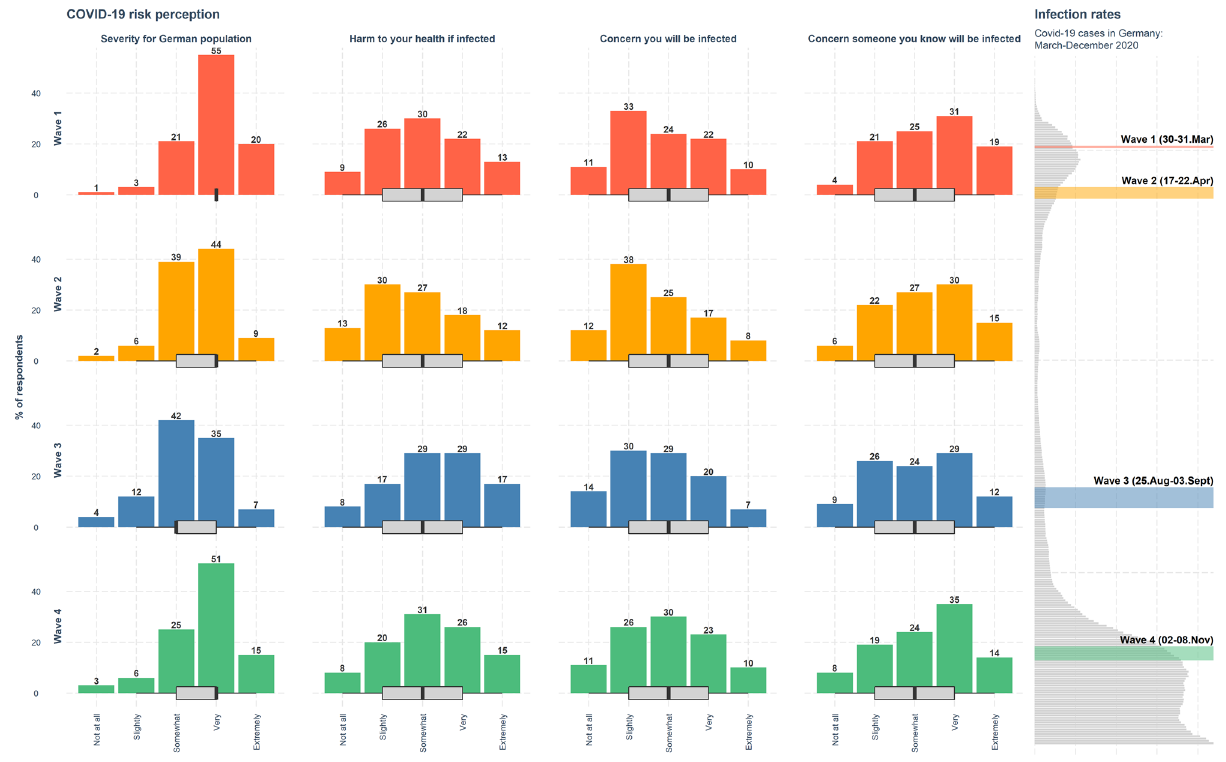
Figure 3. Perceived risks from COVID-19 across the four waves of the study. Barplots show the distribution of responses to the four items (with percentages). Boxplots show the interquartile range (IQR; responses between the 25th and 75th percentiles); the black line within each box indicates the median value. Lower and upper whiskers extend from the hinge to the smallest and largest values within 1.5 × IQR . Plot on the